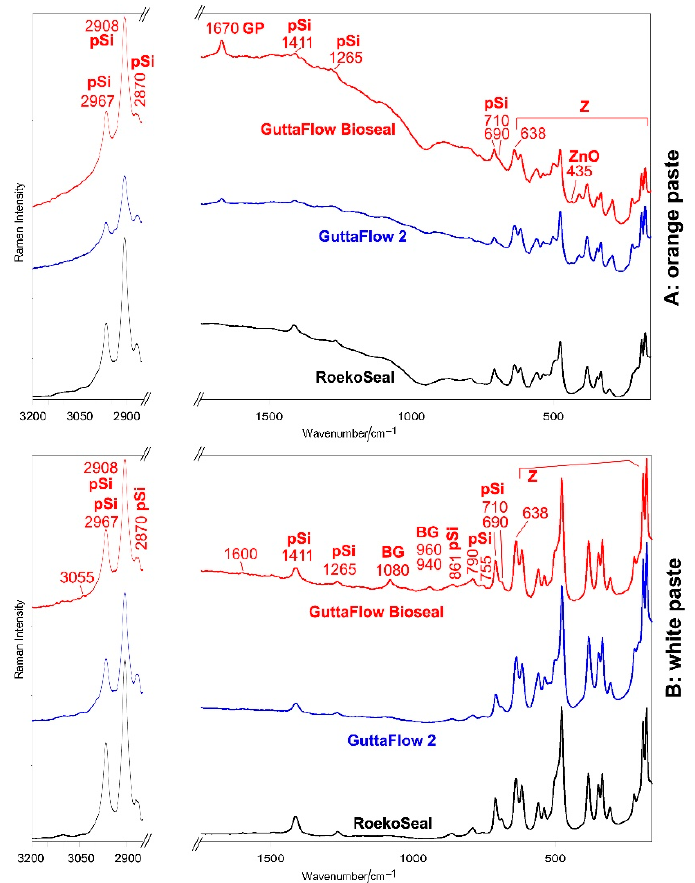
Figure 4. Average FT-Raman spectra of orange ( A ) and white ( B ) pastes of RoekoSeal, GuttaFlow 2, and GuttaFlow Bioseal. The spectra are normalized to the intensity of the 638 cm − 1 band. The bands assignable to monoclinic zirconia (Z), polydimethylsiloxane (pSi), bioactive glass-ceramic (BG), zinc oxide (ZnO), and gutta-percha (GP) are indicated. More detailed assignments are summarized in Table S2, Supplementary Material.